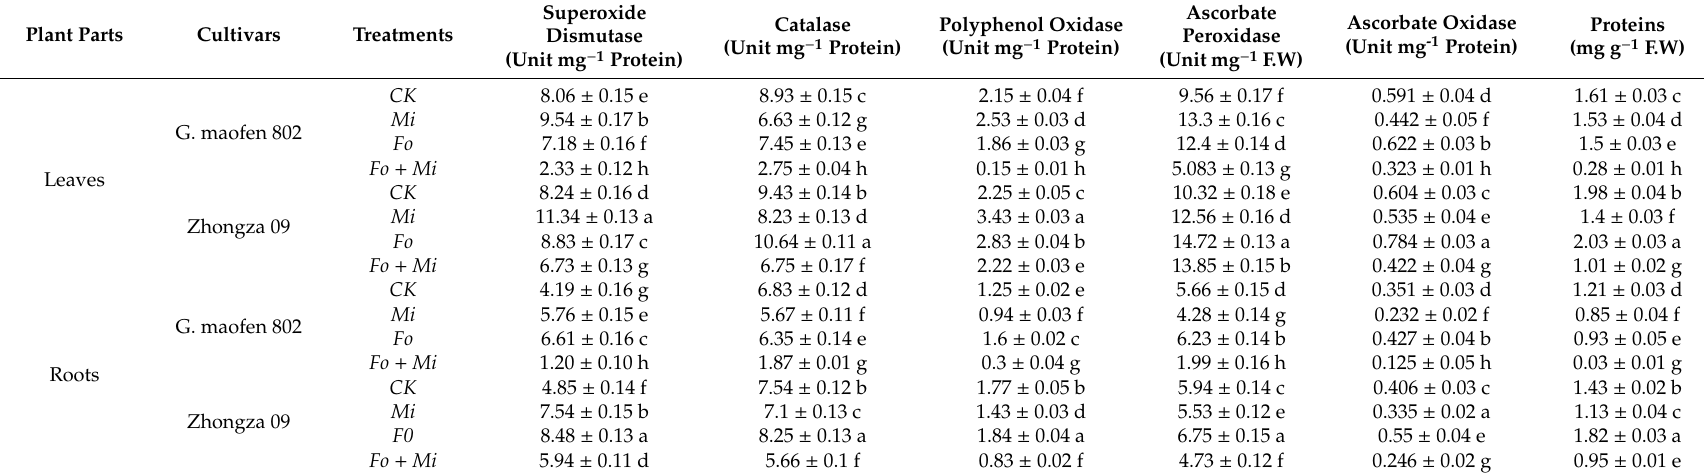
Table 2. E ff ects of Fusarium oxysporum and Meloidogyne incognita alone and in combination on antioxidants of two tomato cultivars (G. maofen 802 and Zhongza 09) under greenhouse conditions after 14